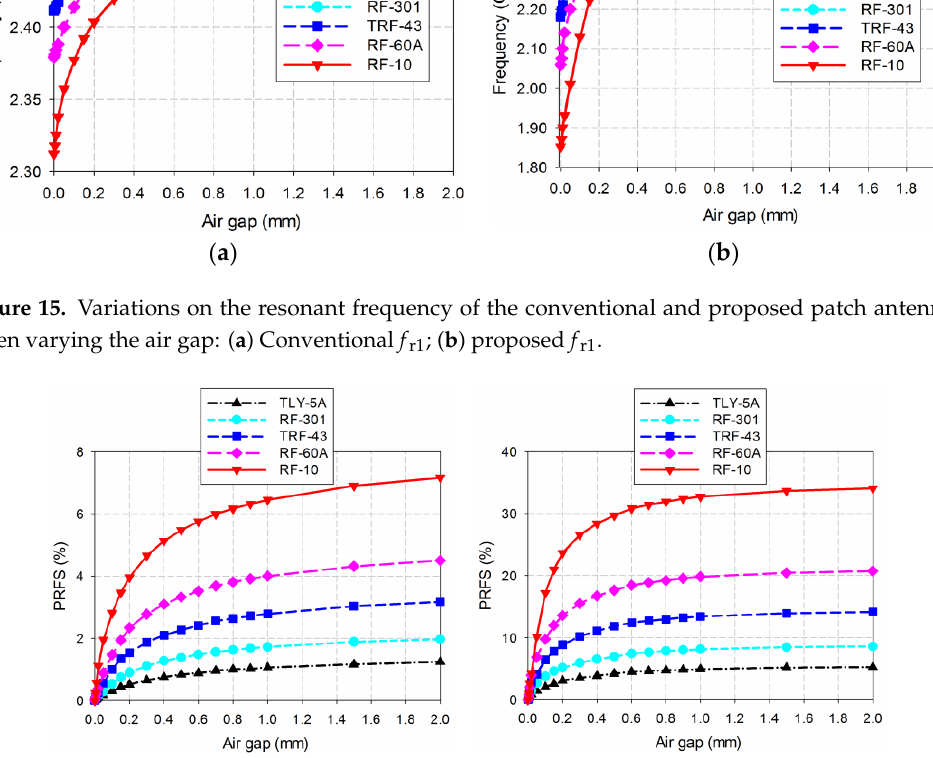
Figure 16. The PRFS of the resonant frequency of the conventional and proposed patch antennas when varying the length of the MUT: ( a ) Conventional f r1 ; ( b ) proposed f r1